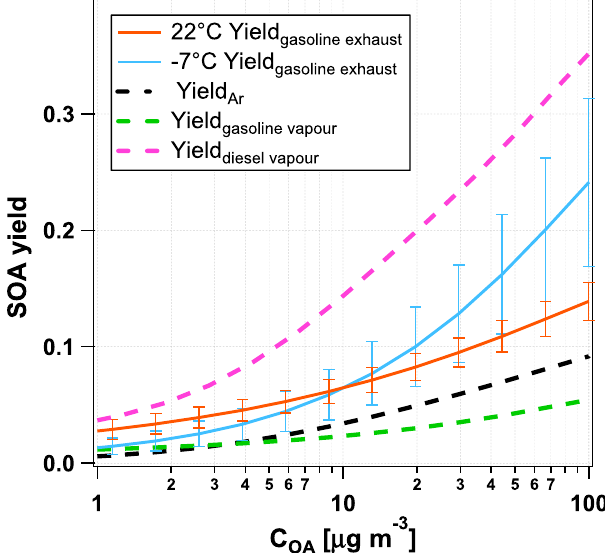
Figure 3. Secondary organic aerosol yields from Euro 5 gasoline car emissions. Modelled secondary organic aerosol (SOA) yields as a function of suspended organic aerosol (C OA ) concentration from three Euro 5 gasoline cars at 22 and − 7 °C (orange and blue, respectively). Error bars represent one standard deviation. Also shown: SOA yields from light aromatic hydrocarbons (Yield Ar ), and diesel and gasoline vapours (Yield diesel vapour , Yield gasoline vapour ), from Jathar et al . 38 . The comparison clearly highlights that SOA yields from gasoline emissions are higher than those based on the fuel aromatic content or expected from gasoline vapour, suggesting the presence of unidentified SOA precursors in the exhaust. Meanwhile, DPF-diesel emissions did not produce any measureable SOA, in contrast to the oxidation of diesel vapours. Taken together both of these observations indicate that SOA yields from gasoline and diesel emissions cannot be predicted based on the yields of fuel vapours. Note that the gasoline car SOA yields are not corrected for vapour phase wall losses (see Methods), for the purposes of intercomparison with previous